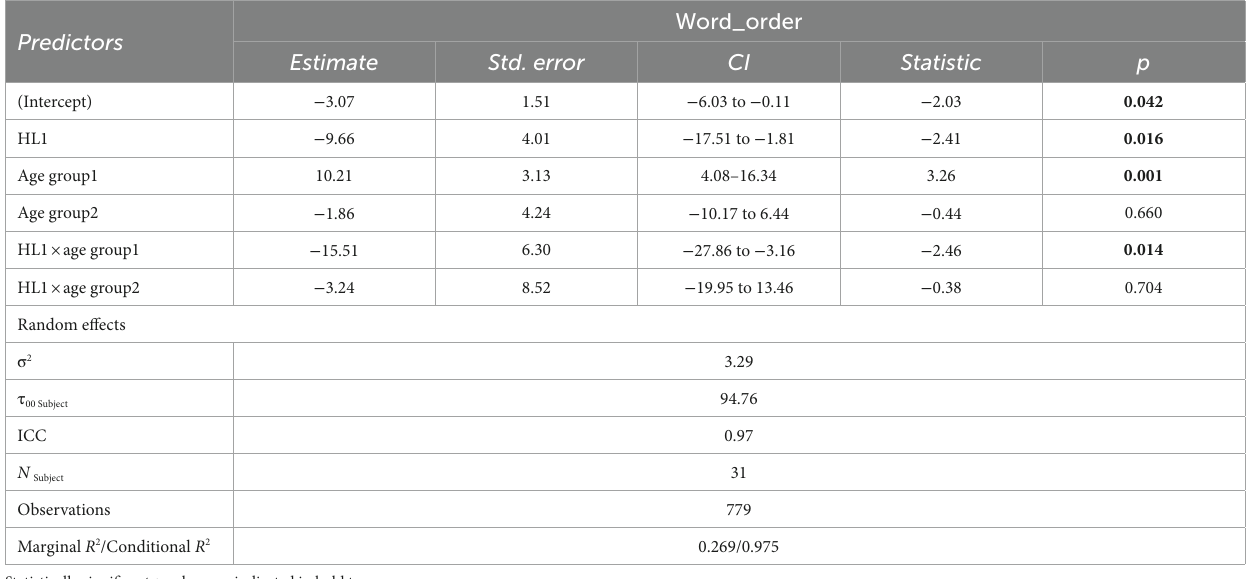
Statistically significant p -values are indicated in bold